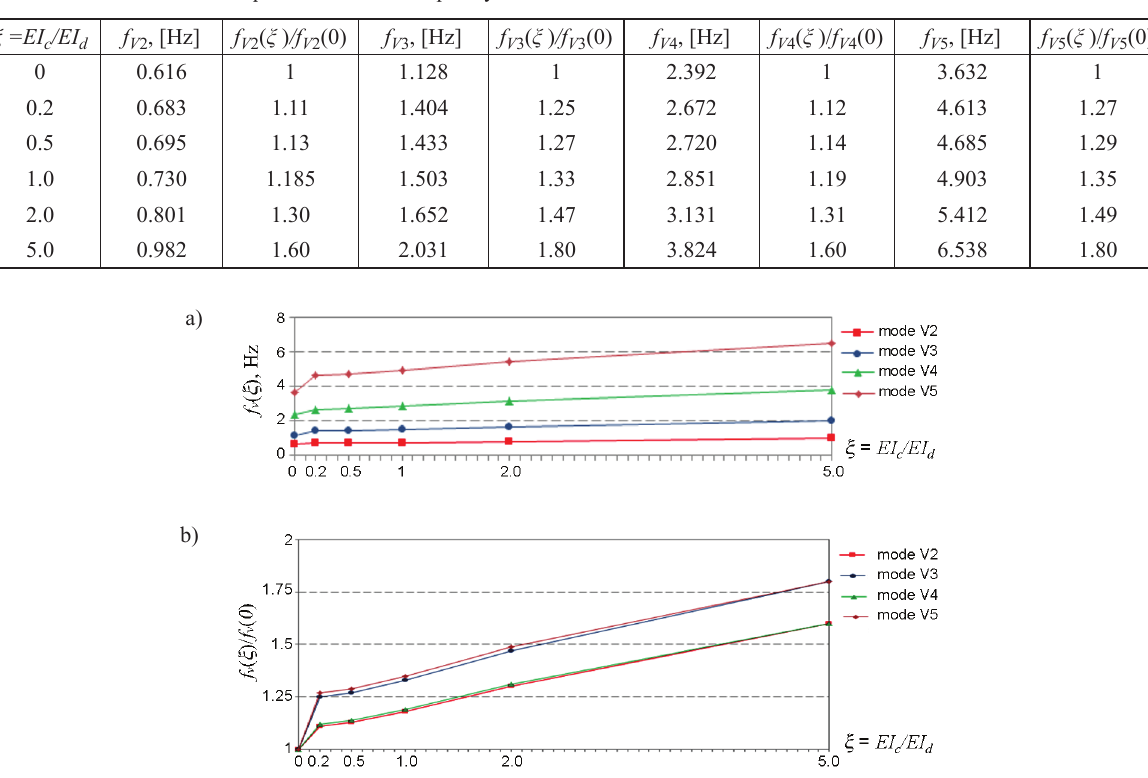
Fig. 7. The effect of the stiffness parameter ξ of the cable on the natural frequencies of vertical modes (a) and the frequency ratio of the system with stiffened cables, f V ( ξ ) and that of the original system, f V